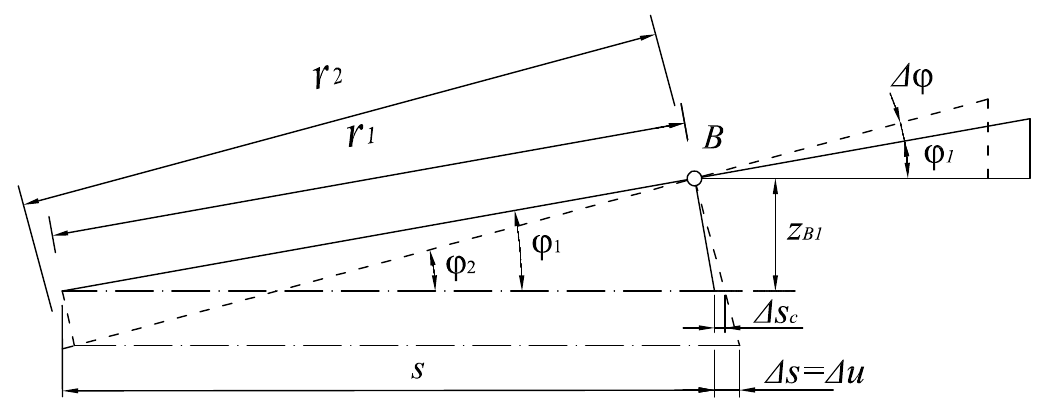
Figure 8. Graphical representation of Δ s c according to Equation (56).